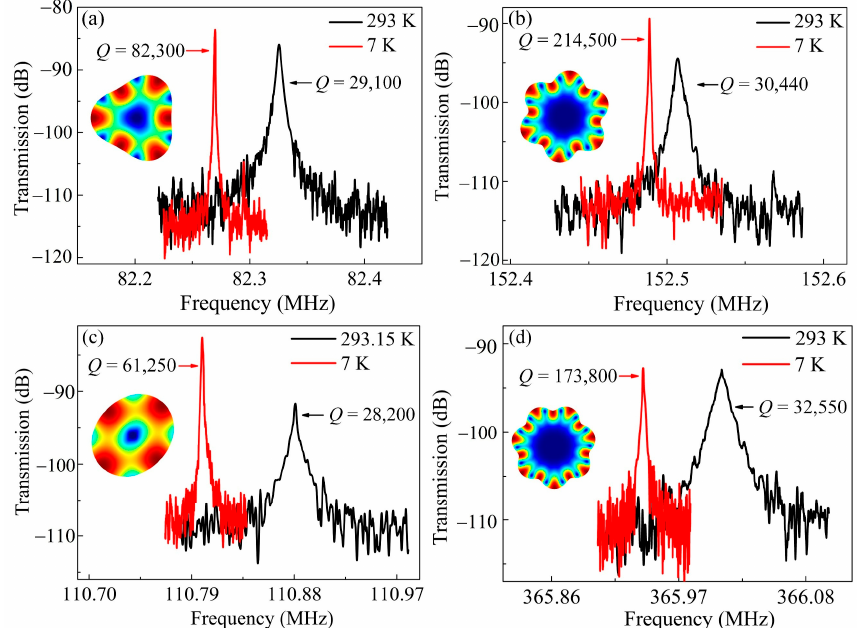
Figure 5. The frequency responses at the room and cryogenic temperatures of the 3rd and 6th WGMs for the 37 μ m-radius resonator ( a , b ), and the 2nd and 7th WGMs for the 18 μ m-radius resonator ( c , d ).